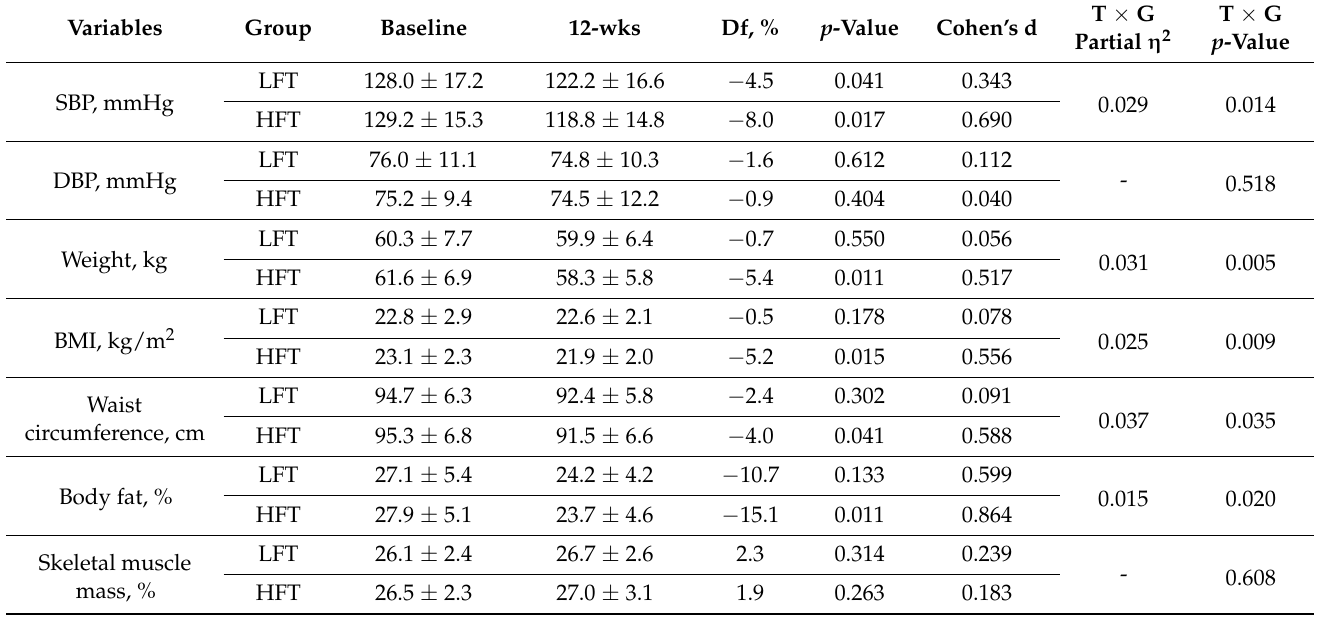
Table 2. Comparison of blood pressure, body mass index, and body